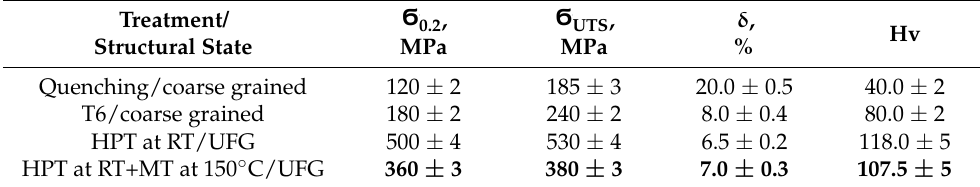
Table 2. Mechanical properties of 6060 Al alloy in different states. Treatment/